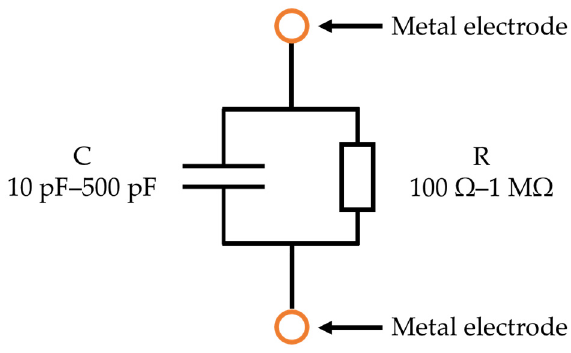
Figure 2. Equivalent circuit of the soil.